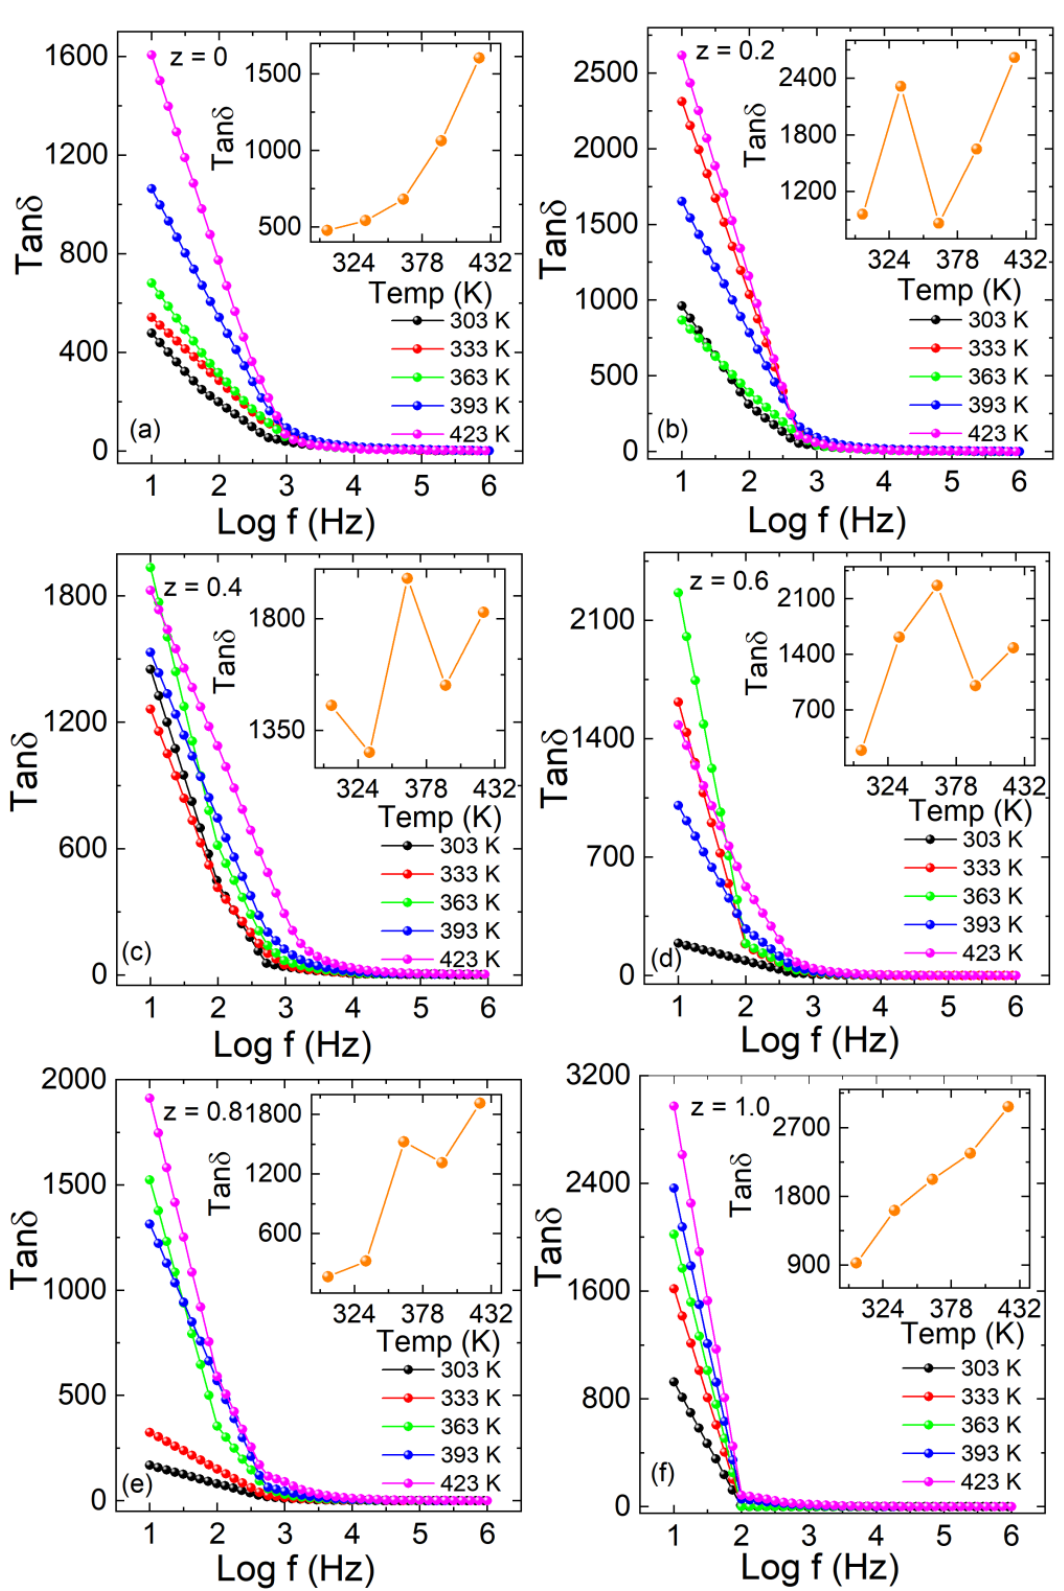
Figure 10. ( a – f ) Dielectric loss (tan δ) versus Log f graph for La 2 Co 1−z Fe z MnO 6 (z = 0, 0.2 – 1.0). Inset of ( a – f ) represents the temperature-dependent dielectric loss part of each plot.